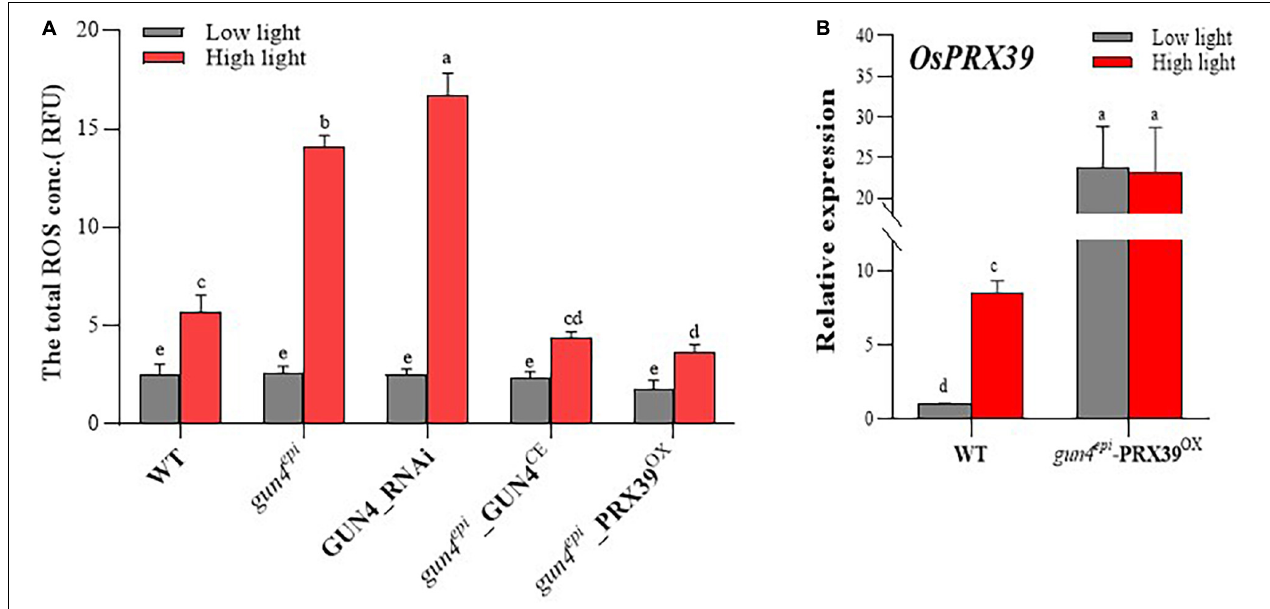
FIGURE 8 | The ROS (A) and OsPRX39 expression (B) levels in rice protoplasts. WT, wild-type variety LTB; gun4 epi : HYB, an OsGUN4 epigenetic mutant of LTB; GUN4_RNAi: LTB protoplasts transformed with an RNAi vector of OsGUN4 ; HYB_GUN4 CE : HYB protoplasts with an OsGUN4 complementary vector, PRX39 OX : HYB protoplasts transformed with OsPRX39 overexpression vector. Protoplasts were prepared from 35-day-old seedlings grown under low light (100 µ mol m − 2 s − 1 ) and transformed with interference or complementary vectors. Transformed protoplasts were initially kept under dark for 1 h and then grown under low (100 µ mol m − 2 s − 1 ) or high light (1000 µ mol m − 2 s − 1 ) for 6 h, before subject to total RNA extraction. The expression level of OsPRX39 are reported relative to that of the WT protoplasts grown at low light, which was assigned a value of 1. Values are means ± SD ( n = 6) and analyzed for significant differences by two-way ANOVA followed by the Tukey’s multiple comparison test, P <